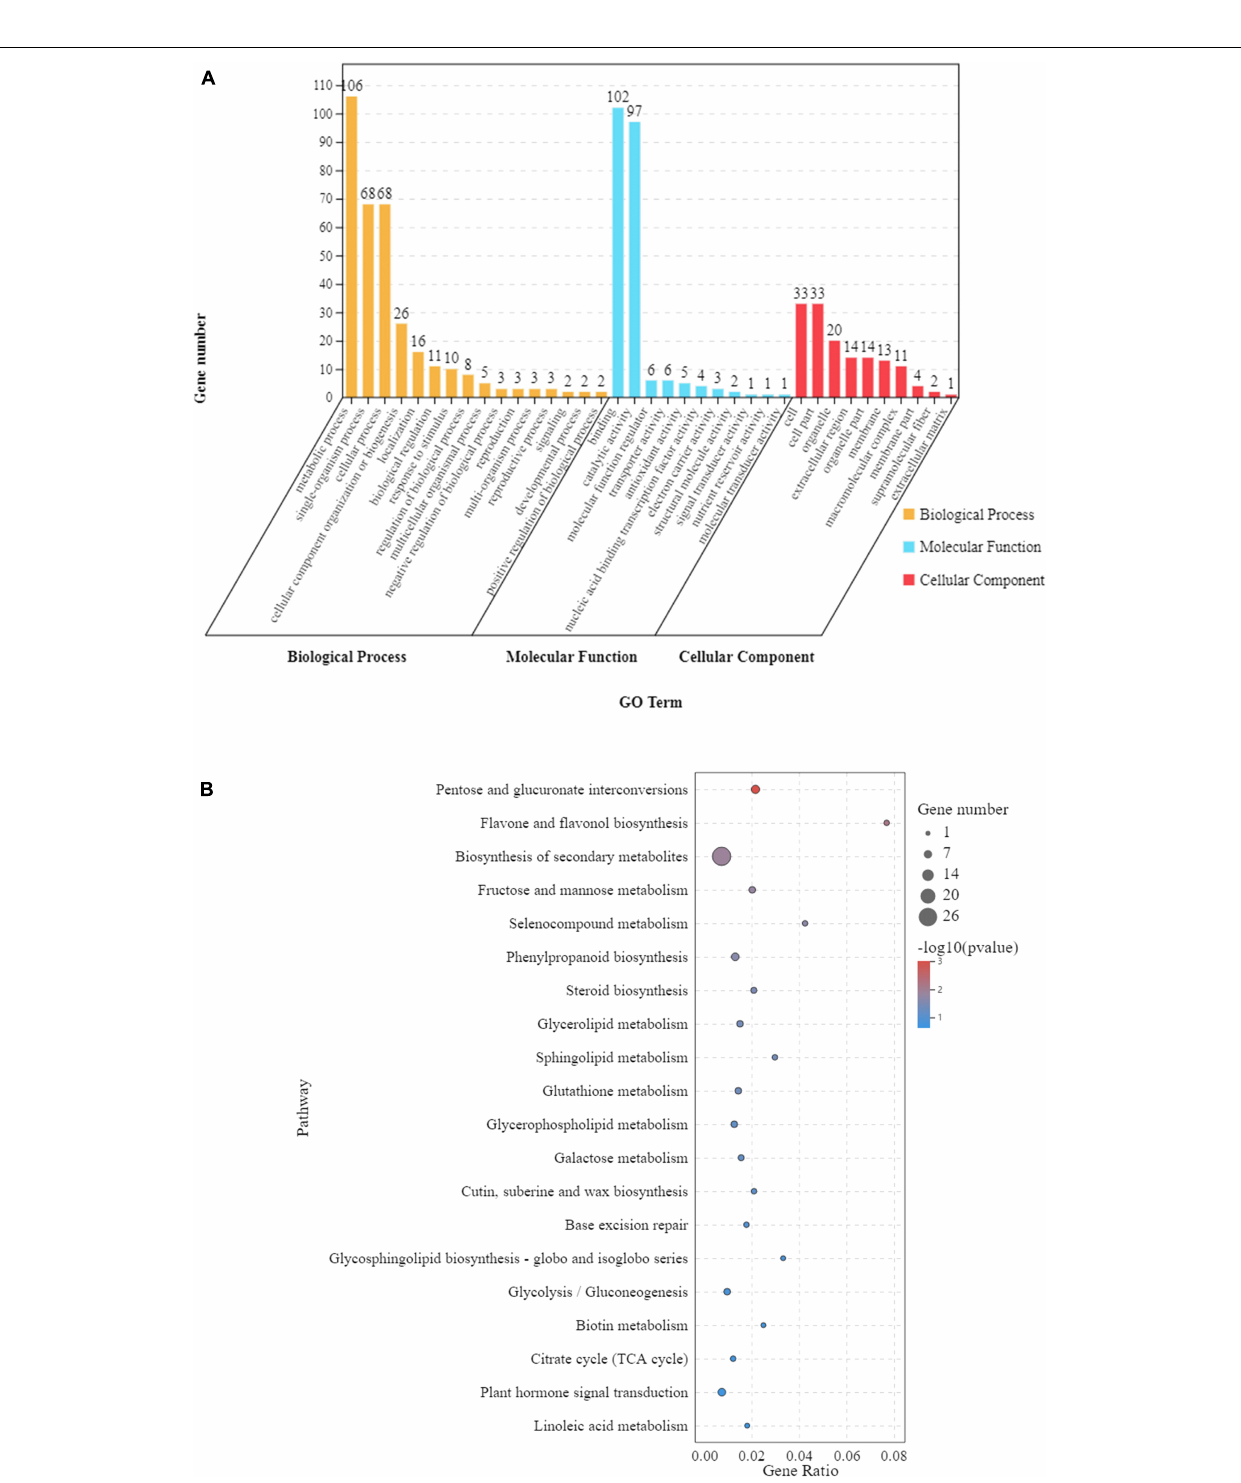
Frontiers in Plant Science |